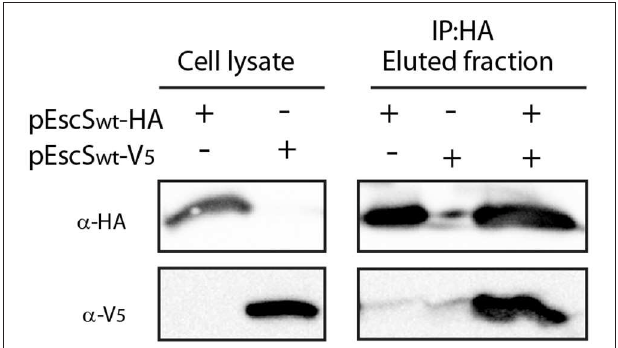
FIGURE 3 | EscS can self-interact. Whole-cell lysates of E. coli BL21 (DE3) expressing either EscS wt -HA or EscS wt -V 5 , were subjected to immunoprecipitation using protein G beads linked to an anti-HA antibody. The lysates were incubated alone or mixed. Whole-cell lysates and elution fractions were separated on a 16% SDS-PAGE and analyzed by western blotting with anti-HA and anti-V 5 antibodies. EscS-V 5 was co-eluted with EscS-HA.